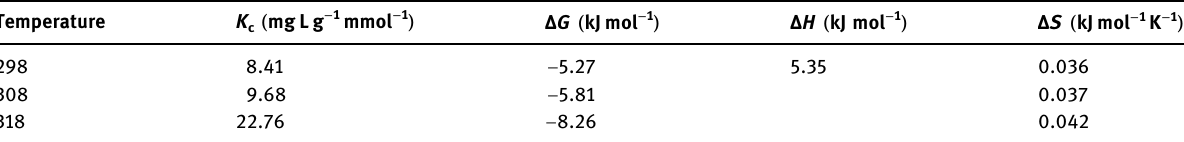
Table 5: Thermodynamic parameters for the adsorption DCP in MSNs Temperature